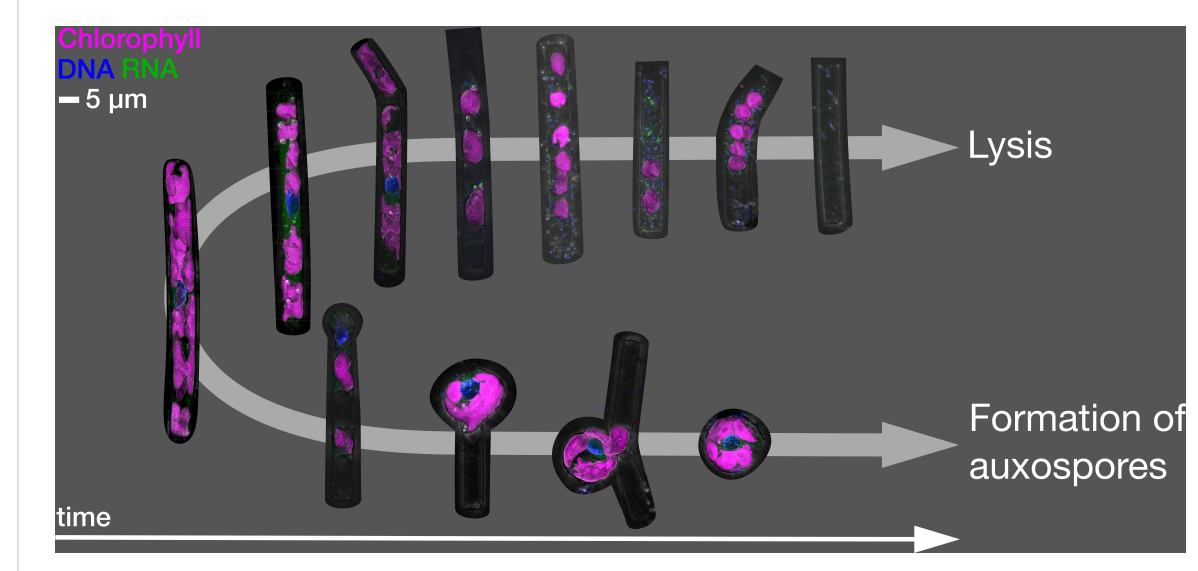
FIGURE 4 Main cellular trajectories in the infected culture. Upper arrow: typical morphologies of virally lysed cells. Lower arrow : auxospore formation. Shown are 3D renderings of selected representative